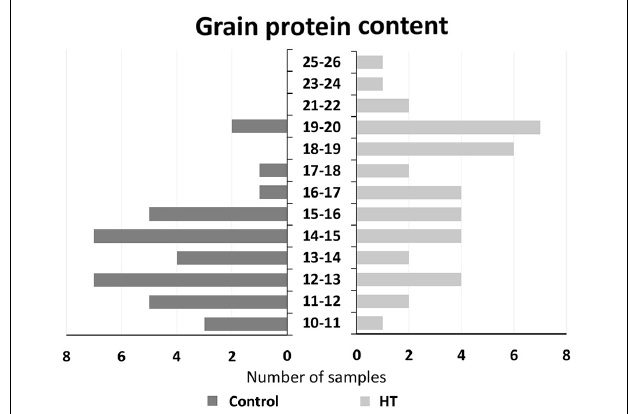
FIGURE 5 | Grain protein content. Distribution of all grain samples protein content from control (dark gray) and HT-treated (light gray) plants of the four landraces